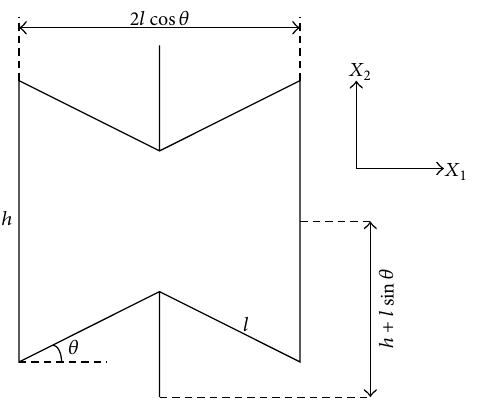
Figure 2: Cell geometry and coordinate system used for the reentrant hexagonal honeycomb, where ℎ is the vertical length of the cell member, 𝑙 is the inclined length of the cell member, and 𝜃 is the cell angle.